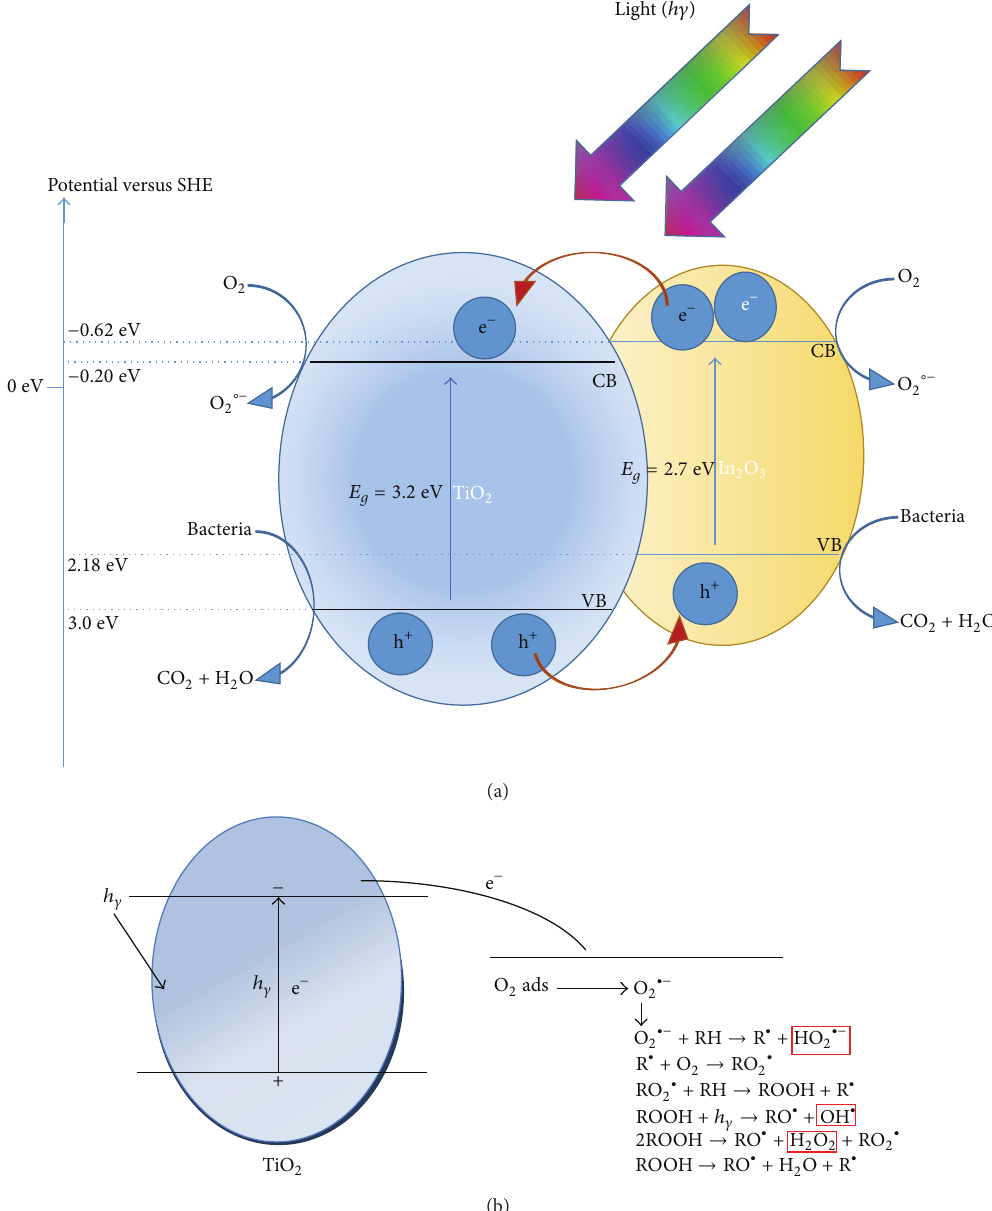
Figure 12: (a) Scheme of the charge injection during the interfacial charge transfer (IFCT) between In 2 O 3 and TiO 2 under simulated sunlight. (b) Radical(s) reaction generated from O 2 reduction on TiO 2 (R: bacteria degradation or species produced during the bacterial degradation).